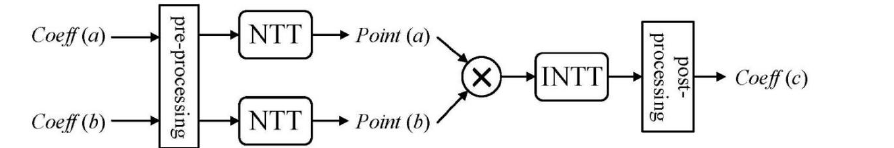
Figure 6. The flow of NTT based polynomial